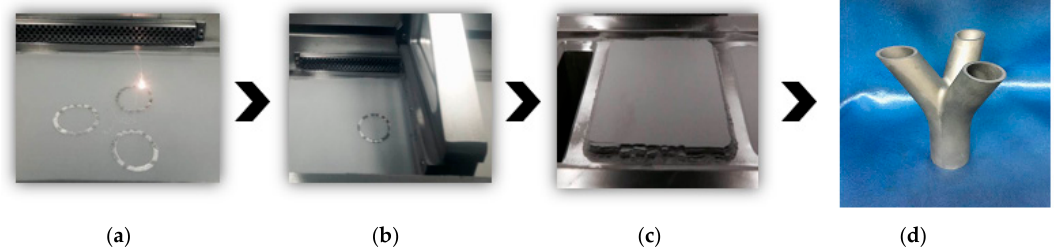
Figure 10. Printing process of SLM technology: ( a ) the laser beam is printed according to the planned path; ( b ) after finishing printing of one layer, put powder on the layer to continue printing; ( c ) the manufacturing of the model is completed after a layer-by-layer scan; ( d ) after cleaning the powder, a trifurcated steel joints model was obtained.